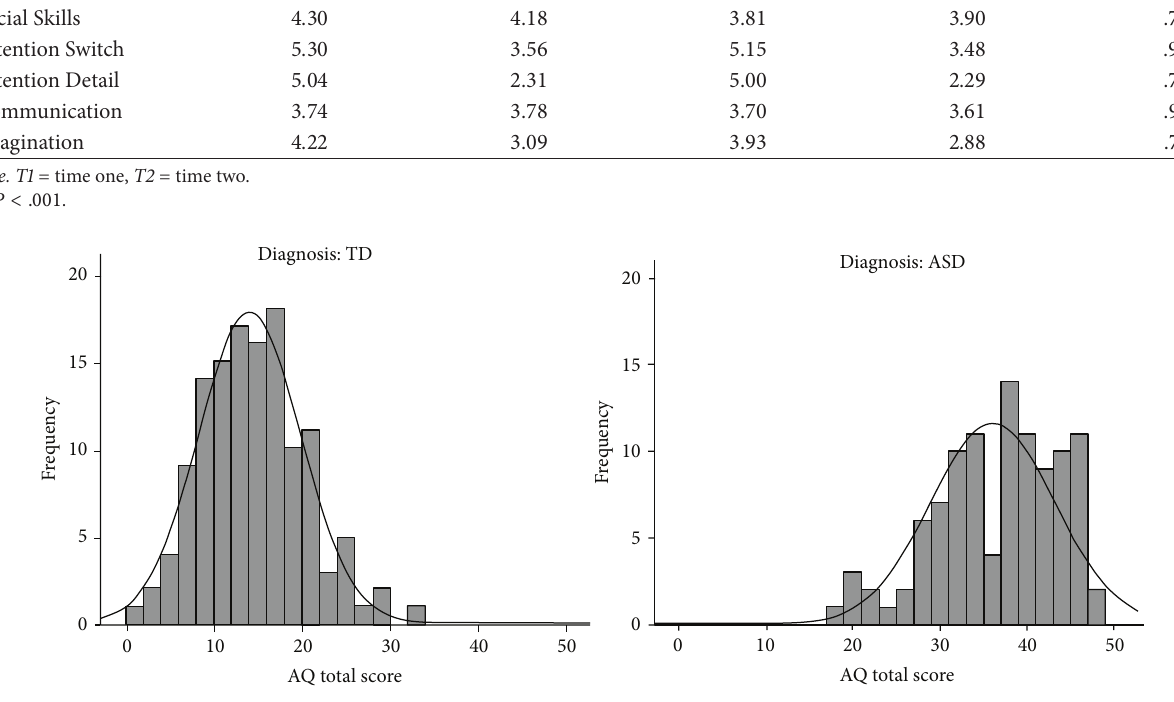
Figure 1: Frequency of Total AQ score by